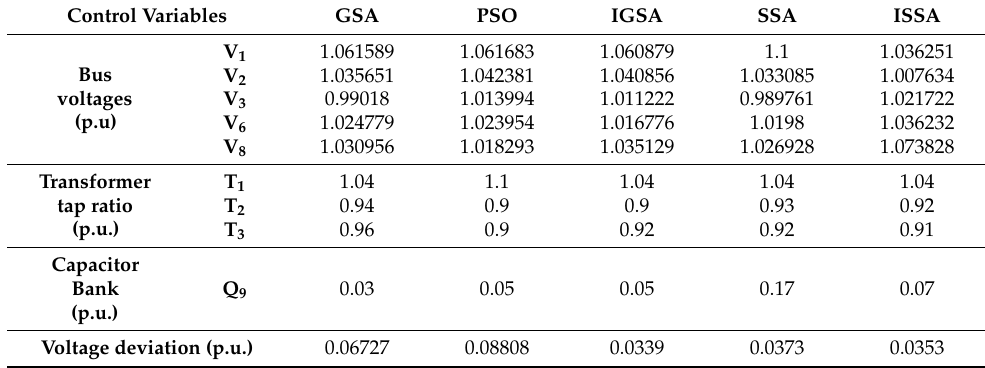
Table 6. Optimal control variables settings for voltage deviation minimization for IEEE 14-bus system.